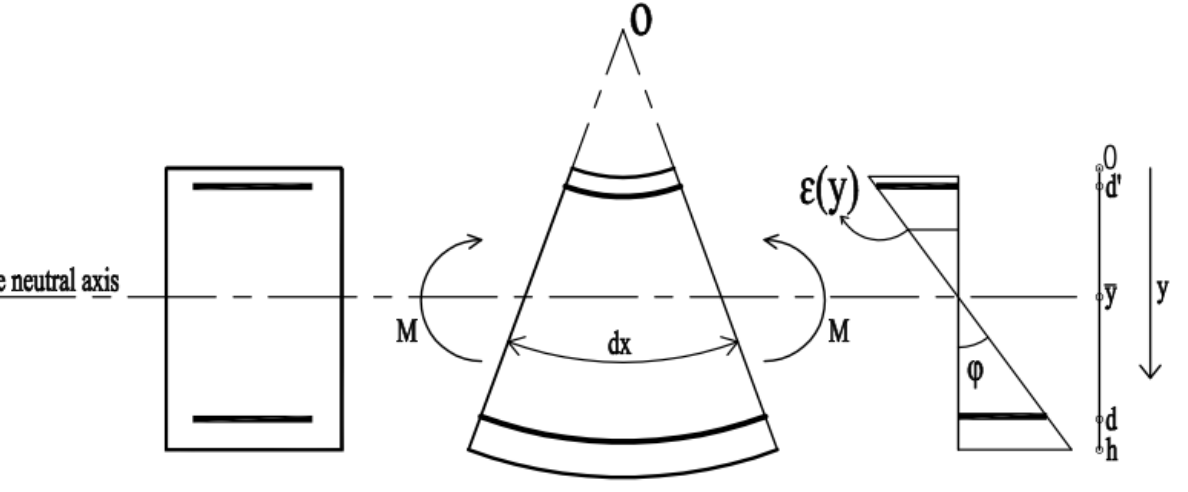
Figure 6. Free body diagram for RC element.